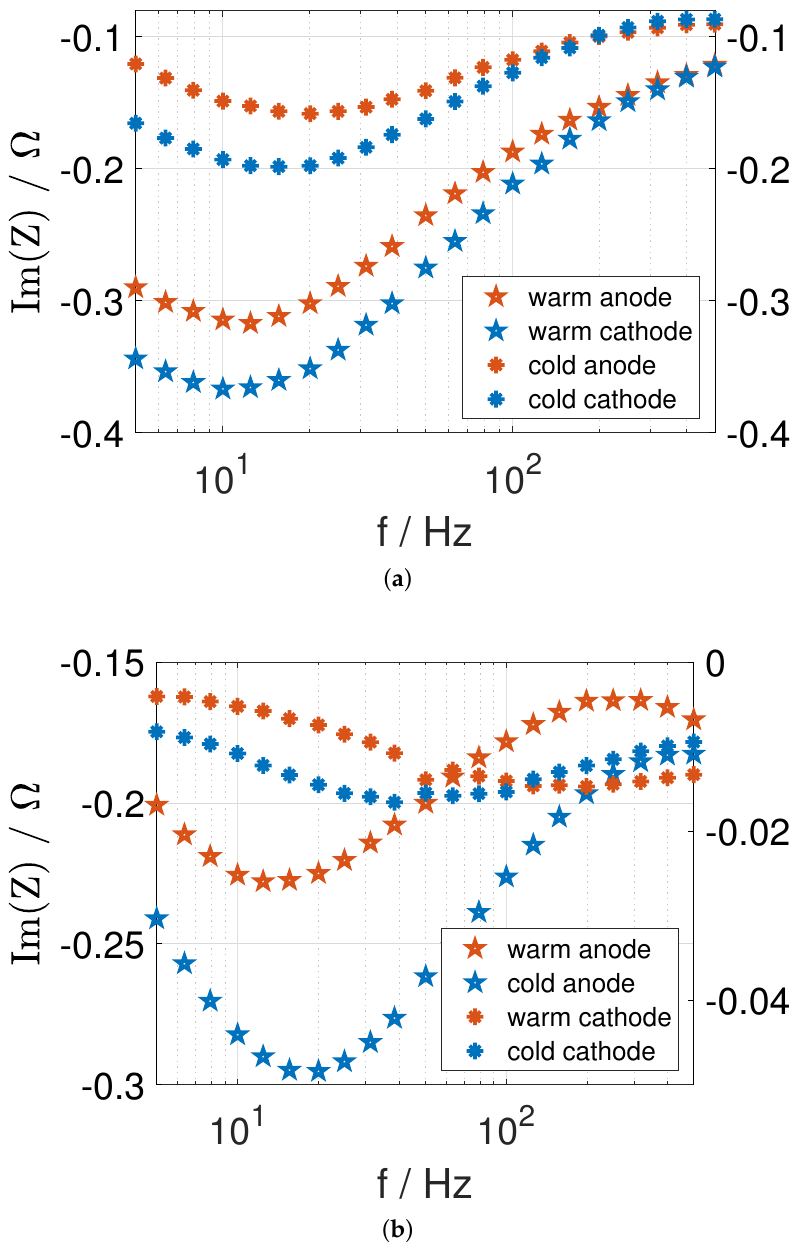
Figure 10. Imaginary part of the impedance for half-cell measurements with a temperature distribu- tion from ≈ 54–59 ◦ C. Left axis shows anode values and right axis shows cathode values. ( a ) Cell I. ( b ) Cell